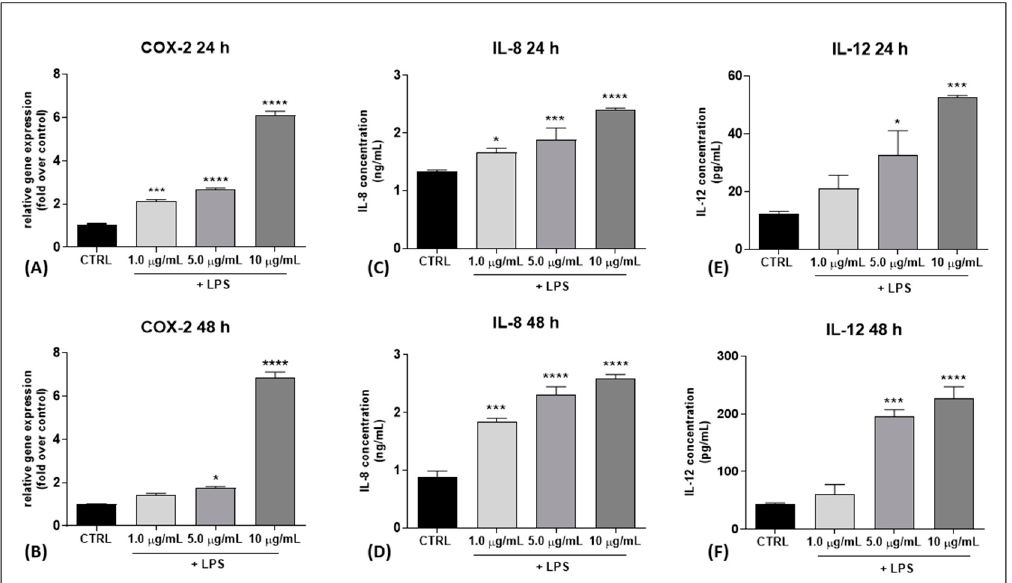
Figure 1. Gene expression of the inflammatory marker COX-2 and release of the pro-inflammatory cytokines IL-8 and IL-12 into the culture medium of HaCaT cells following LPS treatment (at 1.0, 5.0, 10.0 µ g/mL) for 24 h and 48 h. ( A , B ) COX-2 gene expression at 24 h and 48 h, respectively. The values were expressed as 2( − ∆∆ Ct ) and were normalized to β -actin and GAPDH as housekeeping genes. ( C – F ) Release of IL-8 (ng/mL) and IL-12 (pg/mL) at 24 h and 48 h, respectively. All of the data are presented as the means ± SEM of three independent experiments ( n = 3). Statistical analysis was performed using a one-way ANOVA test followed by a Bonferroni post hoc test. ( * p < 0.05; *** p < 0.001; **** p < 0.0001 vs. CTRL).